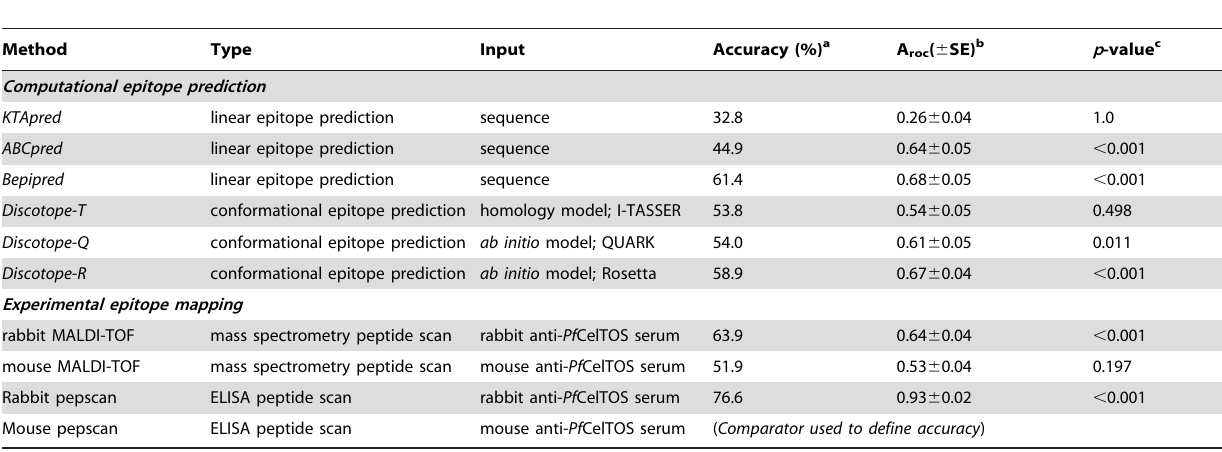
Table 1. B-cell epitope mapping accuracy to mouse anti- Pf CelTOS serum